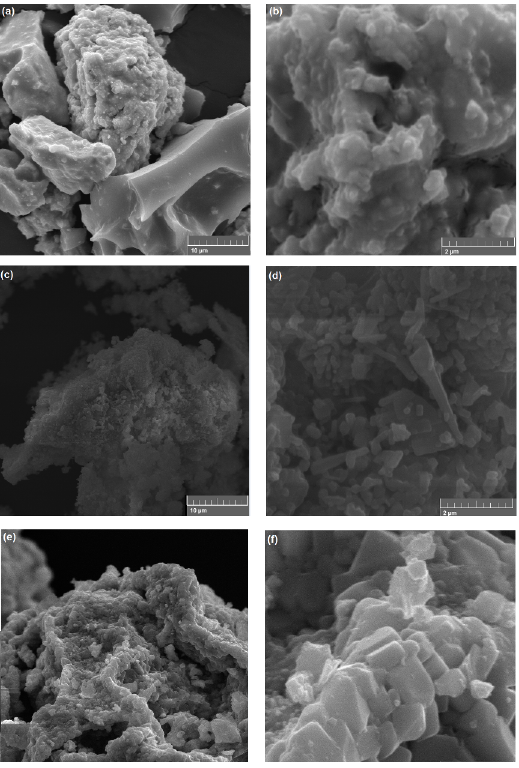
Pr Cu O powders, (A) and 0.8 0.05 0.15 3-δ